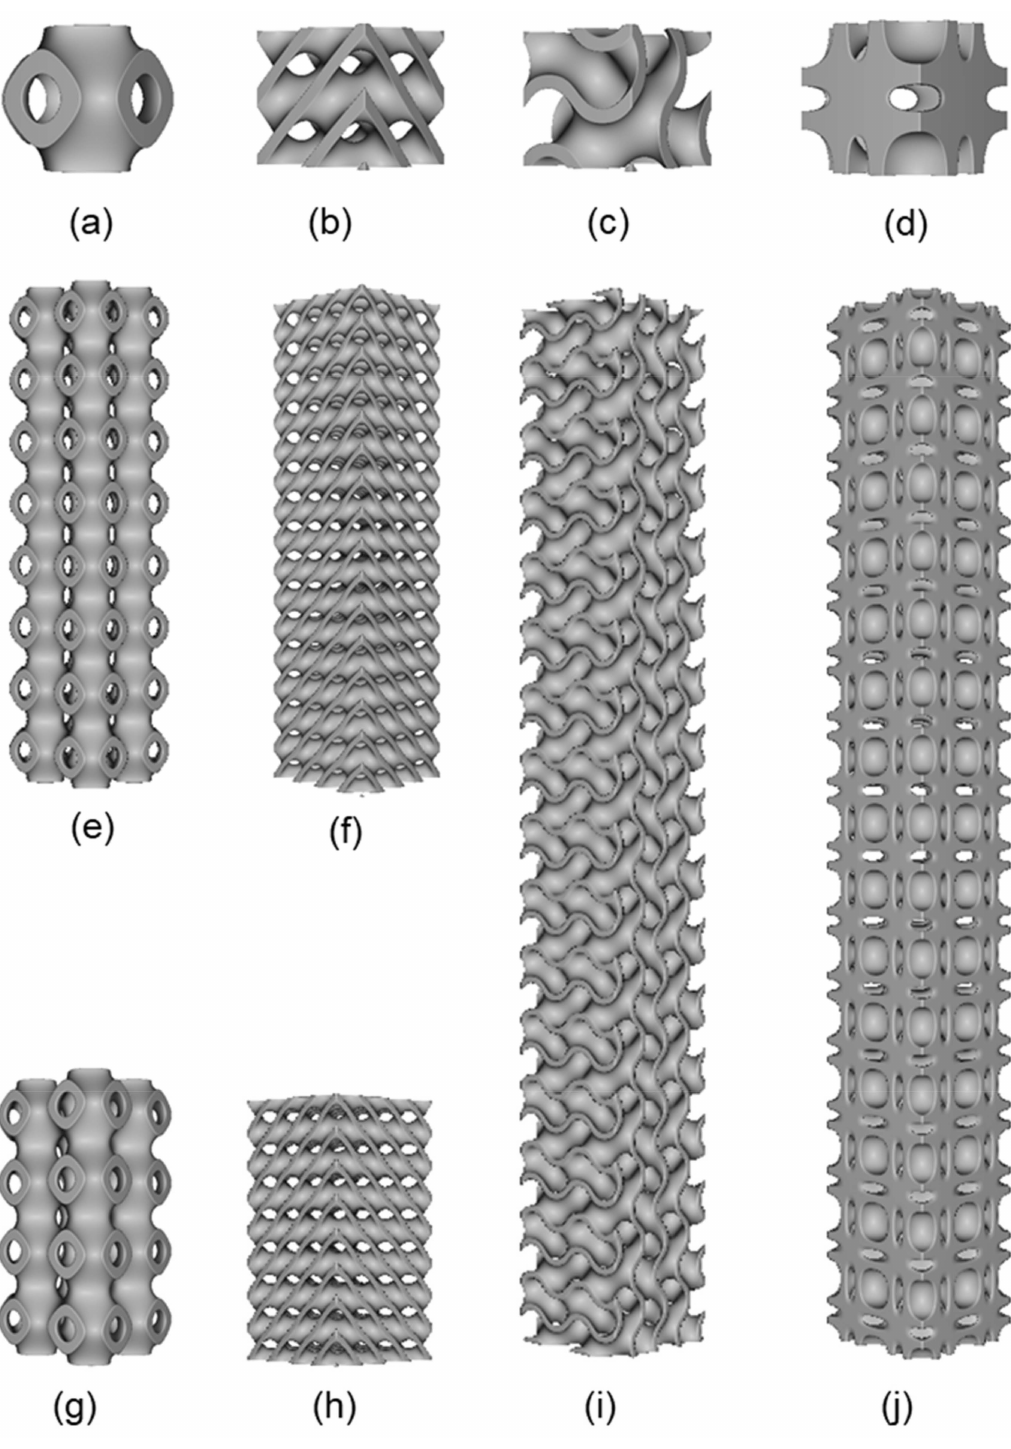
Figure 1. Various design used in this study: ( a ) Schwarz-P unit cell; ( b ) Diamond unit cell; ( c ) Gyroid unit cell; ( d ) Neovius unit cell; ( e ) Schwarz-P (2 × 2 × 8); ( f ) Diamond (2 × 2 × 8); ( g ) Schwarz-P (2 × 2 × 4); ( h ) Diamond (2 × 2 × 4); ( i ) Gyroid (2 × 2 × 16); ( j ) Neovius (2 × 2 ×